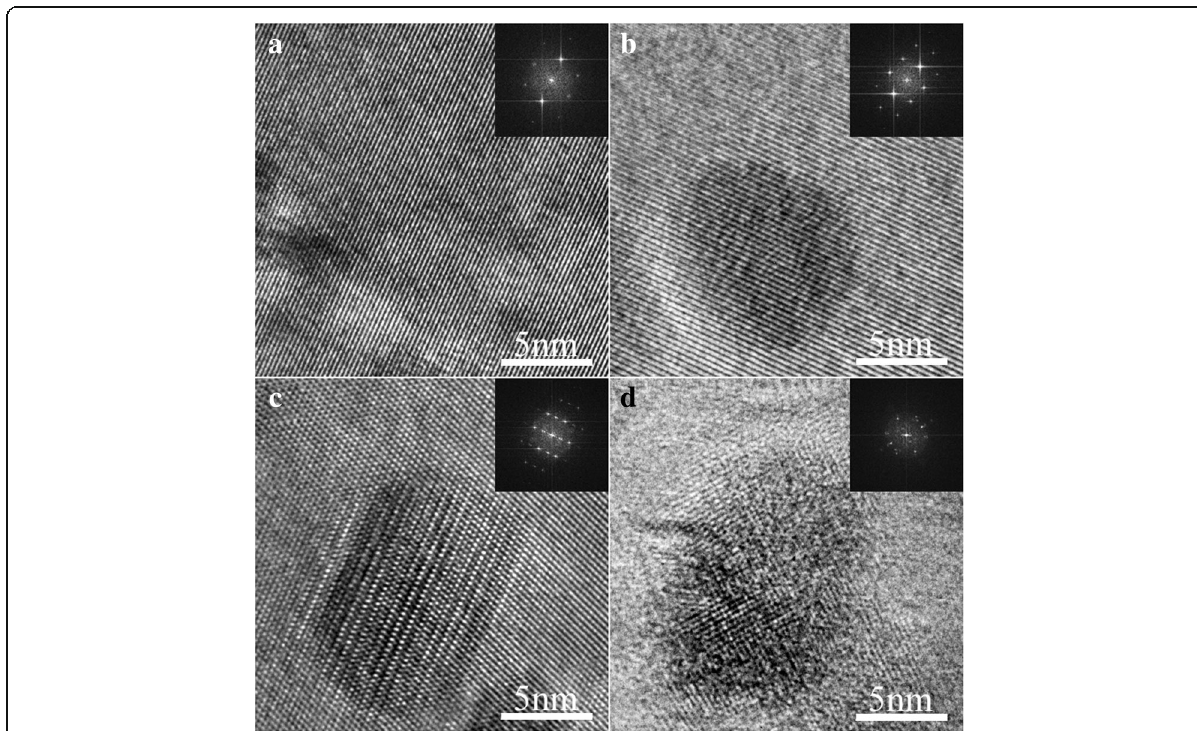
Fig. 2 BF HRTEM images of typical nanoparticles in different states of the second-stage aging process: a UA, b PAI, c PAII, and d OA. Selected area electron diffraction (SAED) patterns near [110], [011], [011], and [001] zone axis are shown as insets in a – d ,